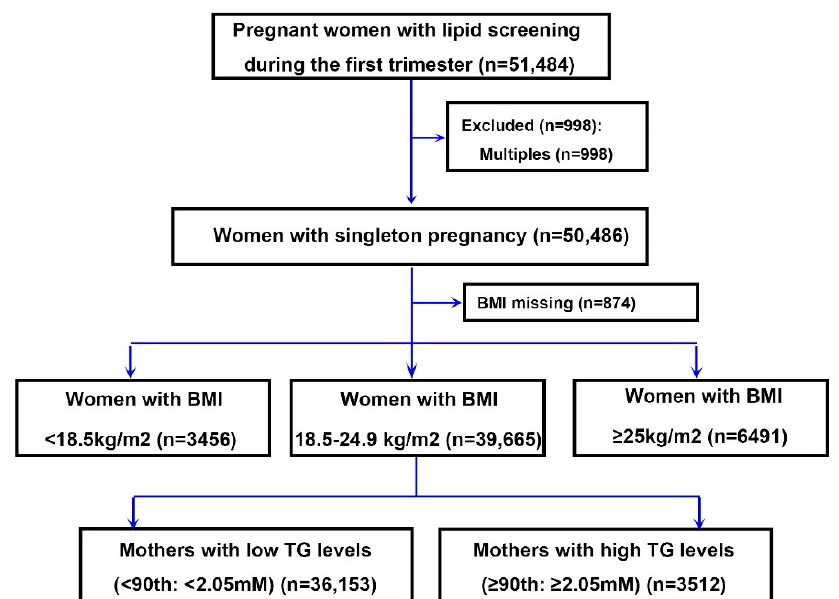
Figure 1. Flowchart for selecting women included in this study.